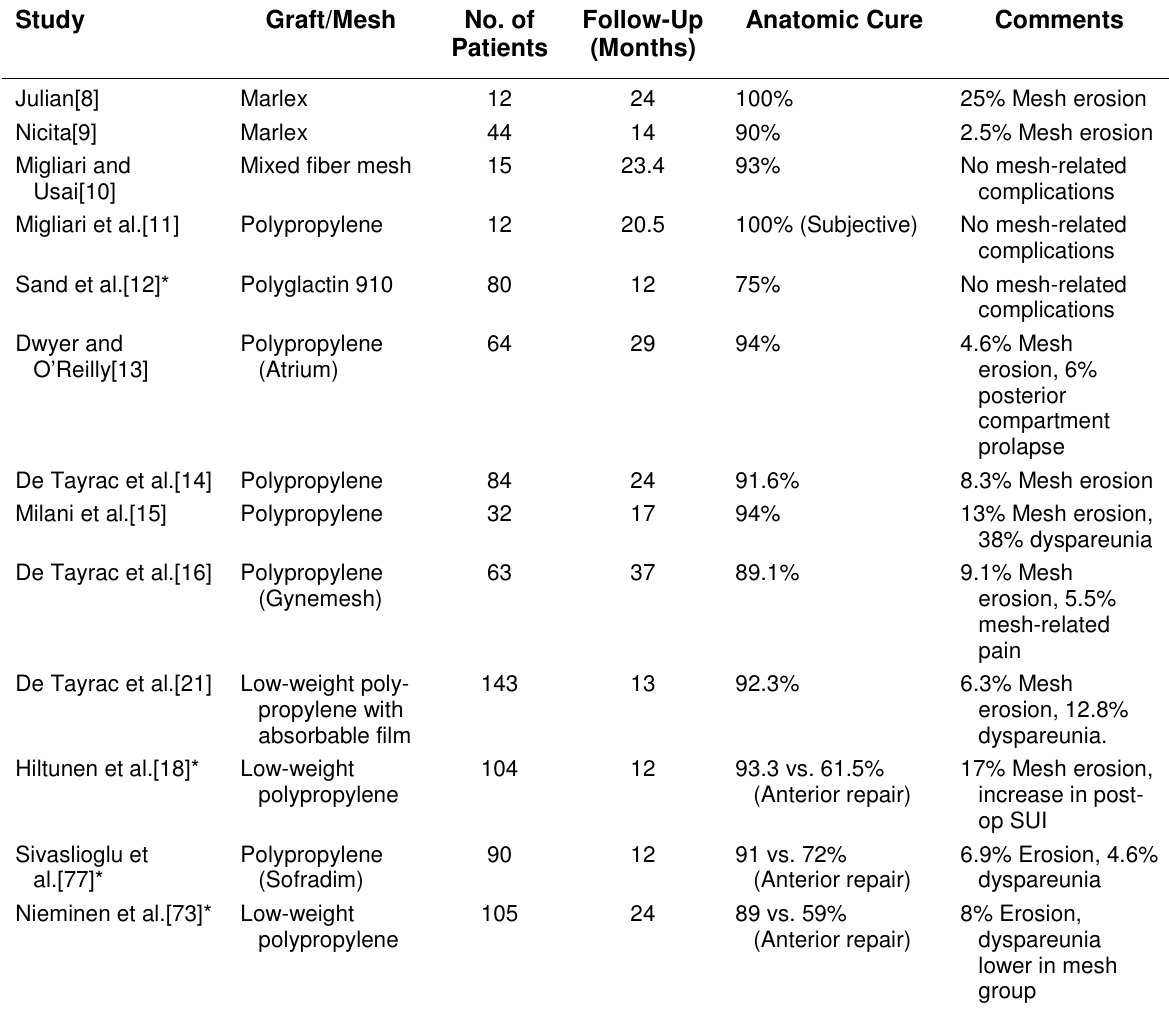
Anterior Prolapse Surgery (Synthetic Mesh)